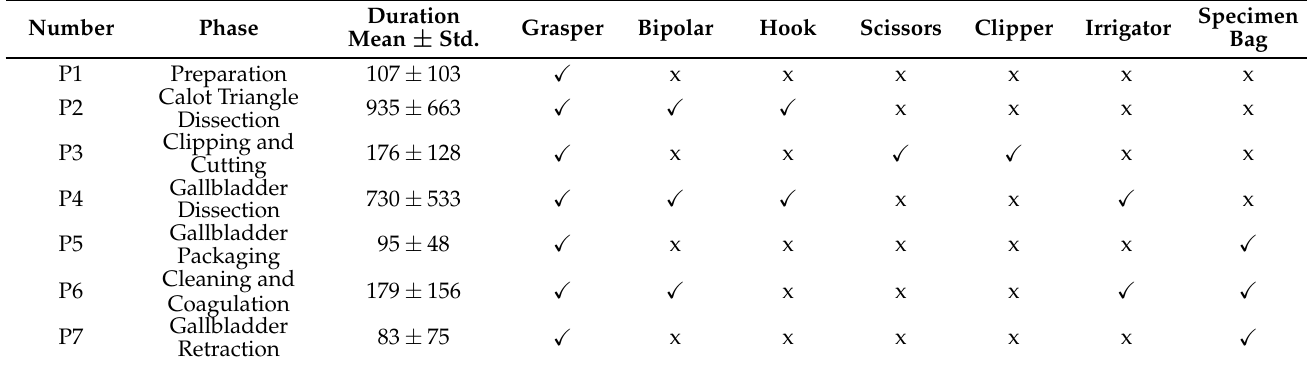
Table 1. Surgical phases and tools in the Cholec80 dataset; (cid:88) indicates the phases in which the tool is often